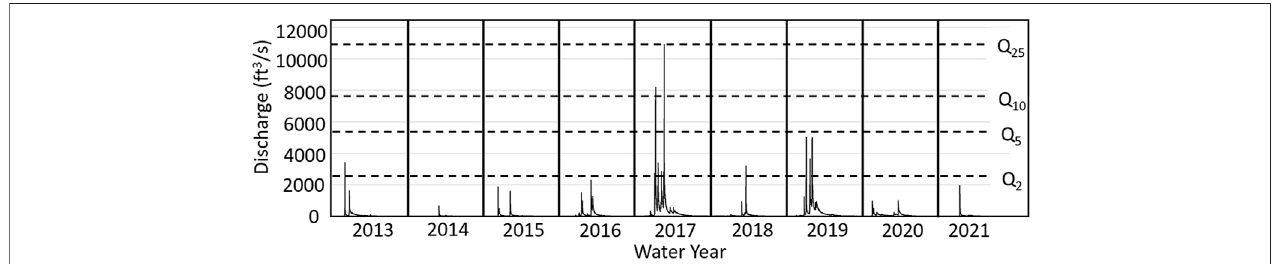
FIGURE3 | Runoff hydrograph for studyperiod. Approximate return period indicated based upon Log-Pearson III frequency analysis.Datafrom USGS Robles del Rio gage (site 11143200; Figure 1 ).